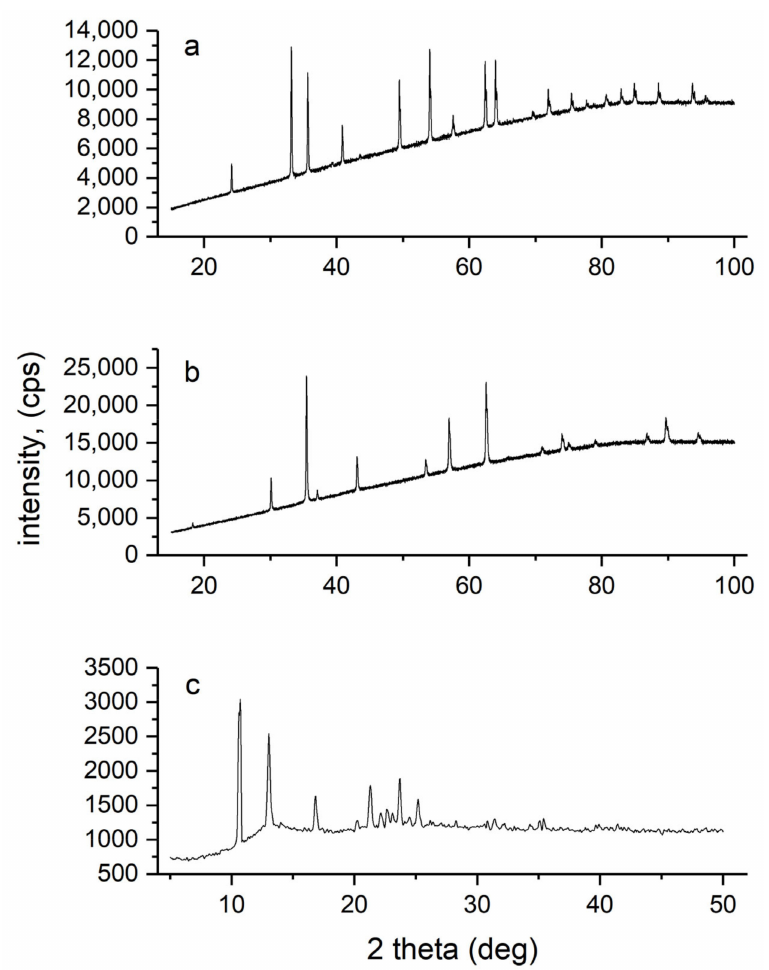
Figure 4. Powder X-rays di ff ractograms of synthesized iron-based fillers: ( a ) hematite; ( b )magnetite and ( c ) tris(acetylacetonato)